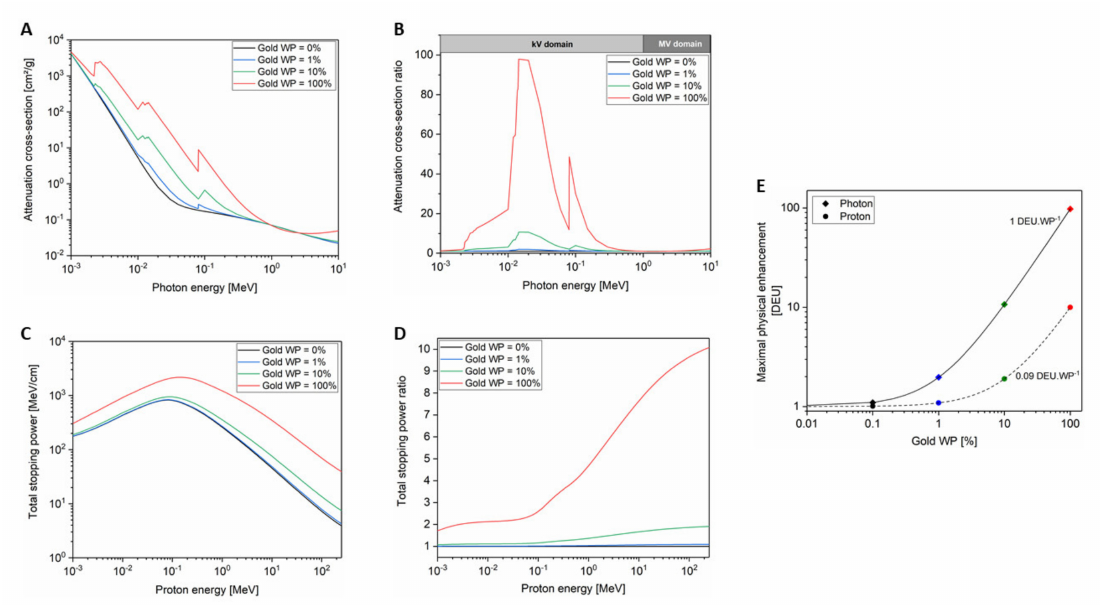
Figure 2. ( A ) Attenuation cross-section of photons in water and gold as a function of photon energy. ( B ) Ratio of gold attenuation cross-section on water attenuation cross-section depending on photon energy. ( C ) Total stopping power in water and gold as a function of proton energy. ( D ) Ratio of gold total stopping power on water stopping power depending on proton energy. ( E ) Maximal dose enhancement for photons (calculated for an energy of 15 keV) and protons (calculated for an energy of 200 MeV) depending on the gold weight percent. An enhancement of 1 DEU (dose enhancement unit) means that the delivered dose doubles when GNPs are present in the medium. Photon and proton data were derived from the NIST XCOM [36] and pstar [37] databases,